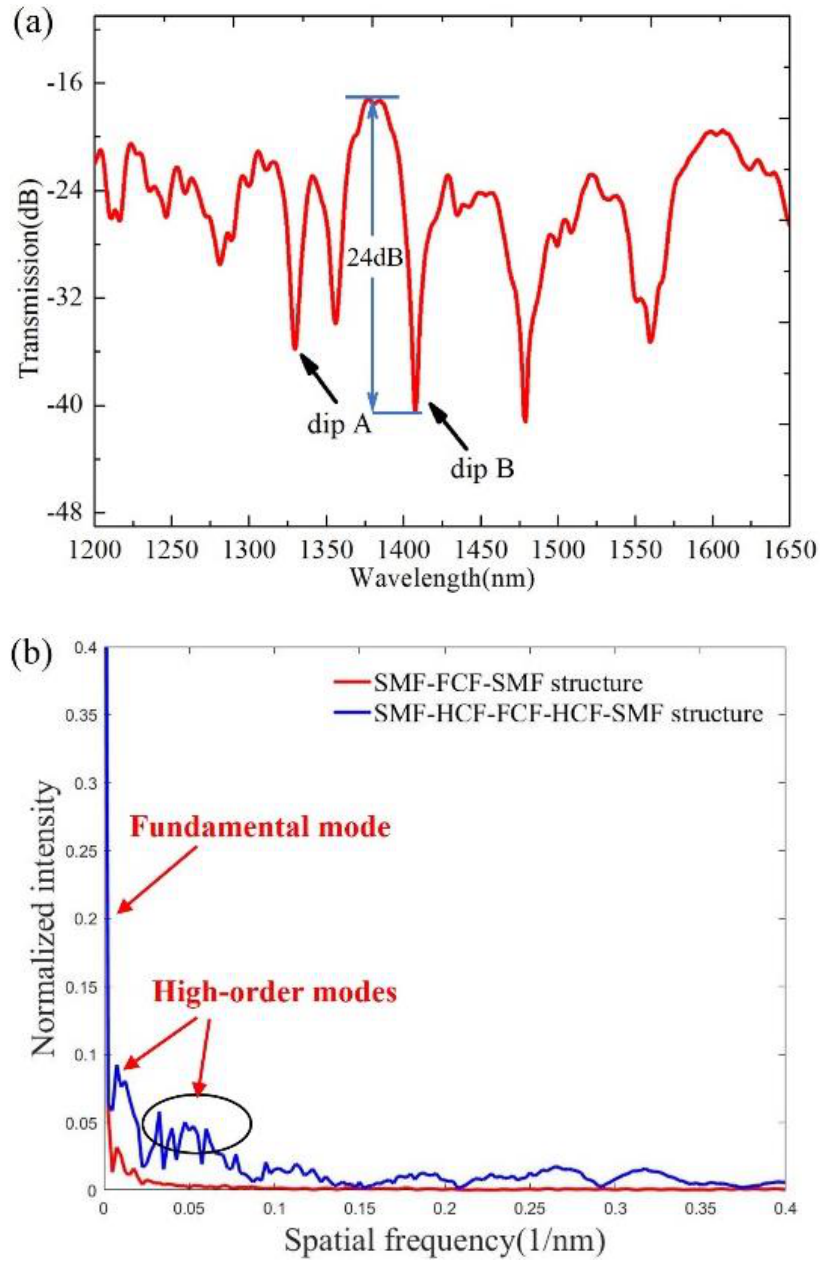
Figure 4. ( a ) Measured transmission spectrum of the sensor head in the air at room temperature. ( b